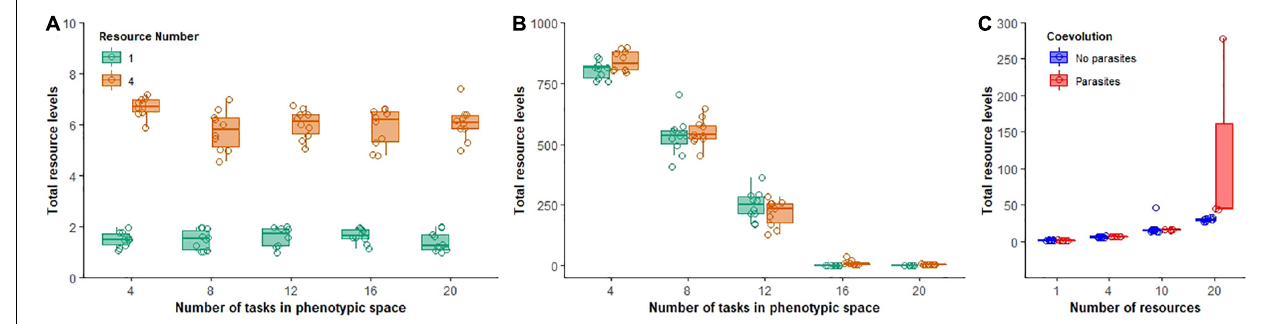
FIGURE 7 | Total excess resource levels that accumulated during evolutionary time. Boxplots show total summed excess resources for non-coevolving populations (A) and coevolving populations (B) in environments of low (green) or moderate ecological complexity (B) . In (C) , non-coevolving (blue) and coevolving (red) populations are shown as ecological complexity